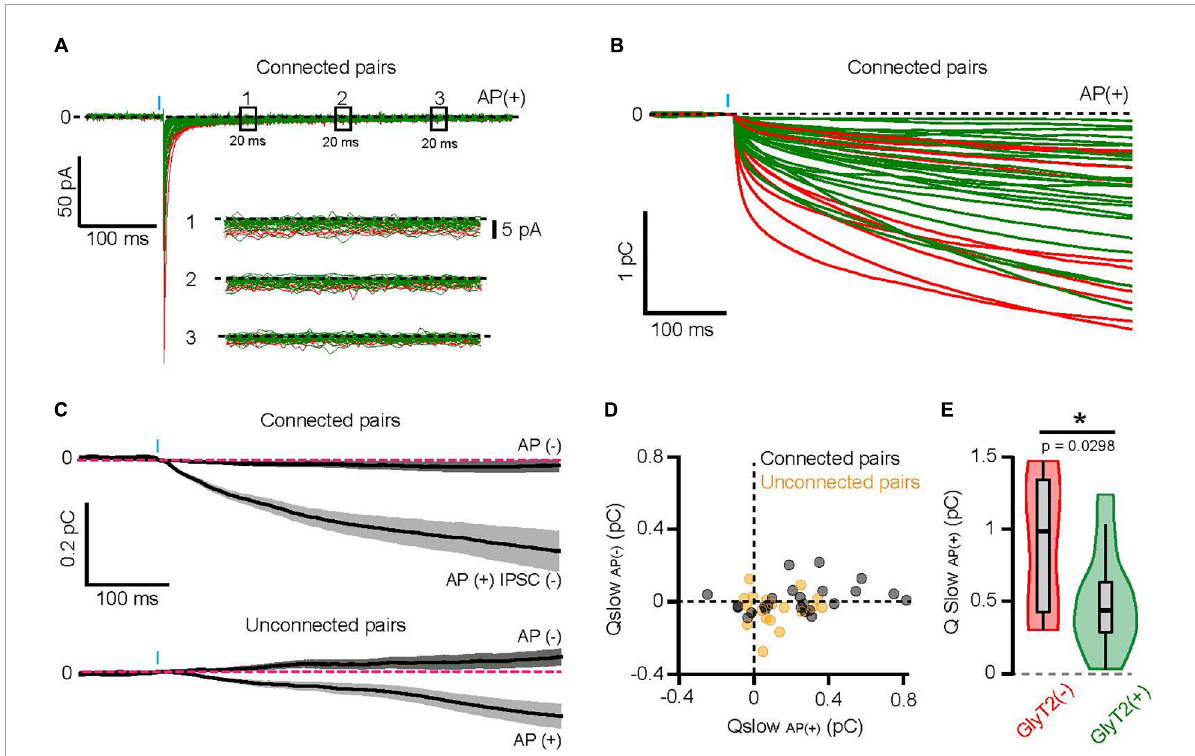
FIGURE5 A stronger activation of high-affinity GABA A R by GlyT2( − ) GoCs. (A) Full scale averaged IPSCs from GlyT2( − ) and GlyT2(+) GoC-GrC paired recordings. Windows (1), (2), and (3) correspond to 20 ms of recording at 100, 200, and 300 ms from the IPSC peak, respectively. Insert shows the magnification of windows (1), (2), and (3) where the black dotted line represents 0 pA. (B) Cumulative sum (integral) of the mean AP(+) current for each GoC-GrC pairs (red = GlyT2( − ), n = 10; green = GlyT2(+), n = 27). (C) Average integrals ± SEM for AP failure [AP( − )] or IPSC failure [AP(+) IPSC( − )] in connected (top, n = 24) and unconnected pairs (down, n = 18). (D) Slow component charges (Qslow) in AP( − ) and AP(+) IPSC( − ) mean current from connected (black, n = 24) and unconnected pairs (yellow, n = 18). (E) Violon plot distribution of Qslow AP ( + ) in GlyT2(+) ( n = 25) and GlyT2( − ) ( n = 10) pairs. * p < 0 .